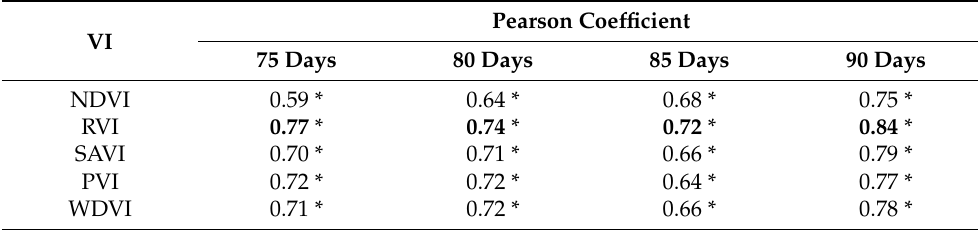
Table 6. The Pearson coefficient representing the relationships between the derived VIs and the yield of the Foster hybrid.